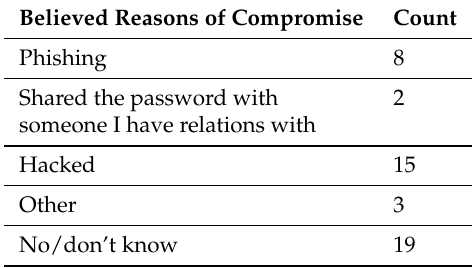
Table 24. Stated reasons of account compromise. N =